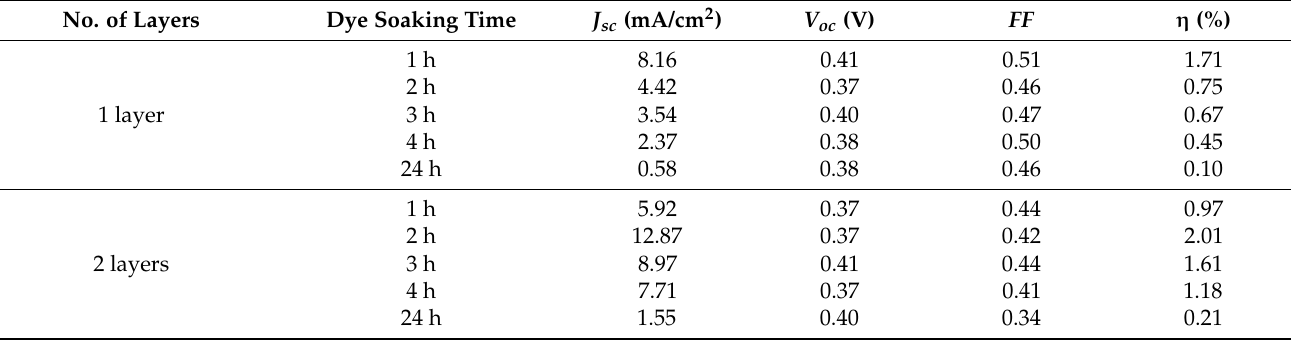
Table 1. One- to five-layered ZnO photoanodes soaked in N719 dye for different soaking times. No. of